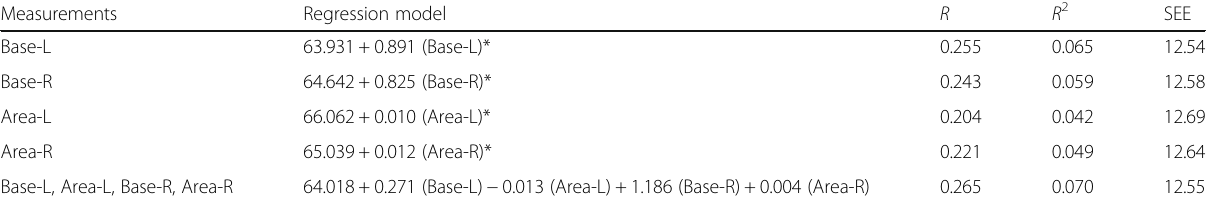
Table 4 Linear and multiple regression models for weight estimation from the base of gait and area swept in one stride